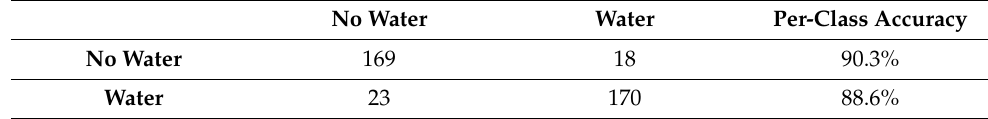
Table 8. Confusion matrix for the MobileNet model onboard Nvidia Jetson